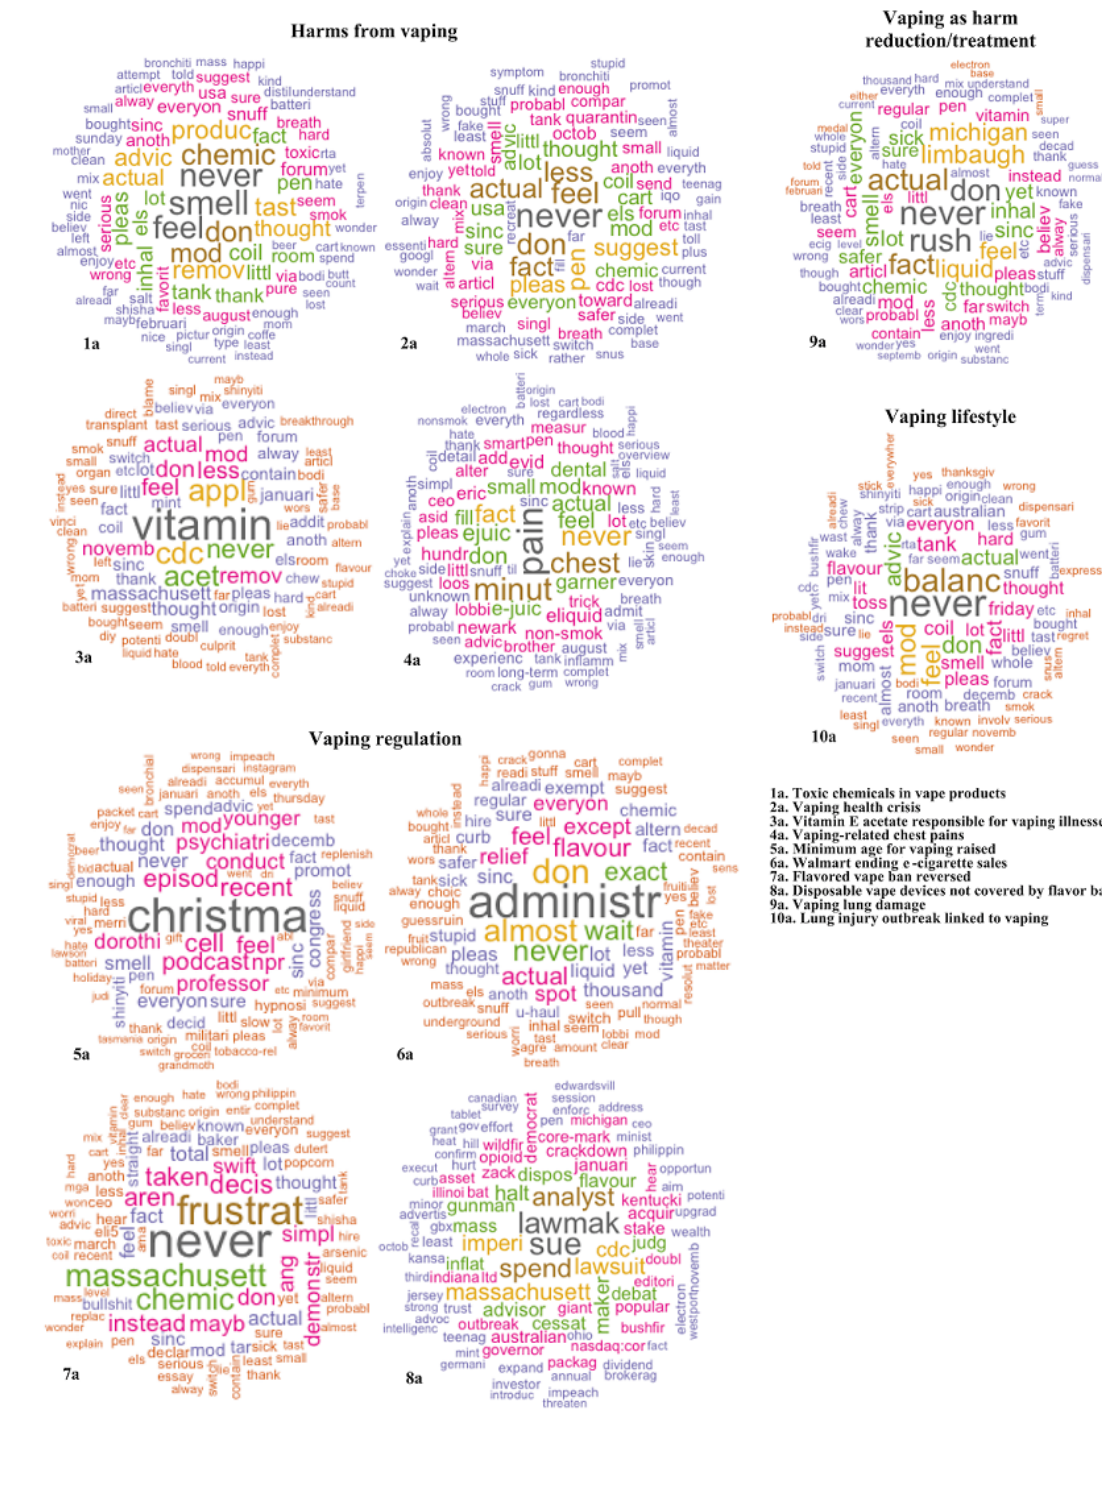
Figure 2. Major archetypes of vaping-related topics with example topics per archetype obtained by structural topic modeling for all observations (August 1, 2019, to April 21, 2020). The word clouds are generated from the weights of the top 100 terms within a topic. Terms with larger weights are depicted in larger font sizes. Terms with approximately the same weight are depicted in the same